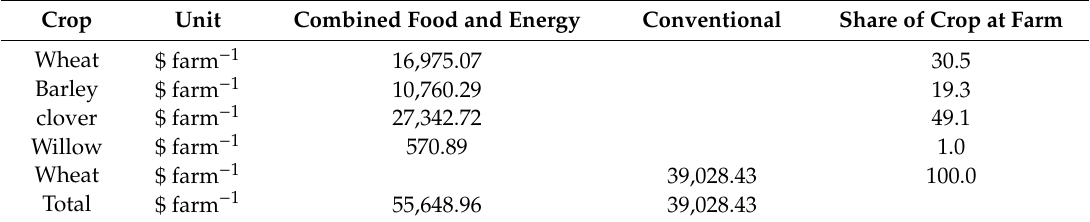
Table 3. Income from the produce in the conventional wheat and combined food and energy production systems in Denmark.